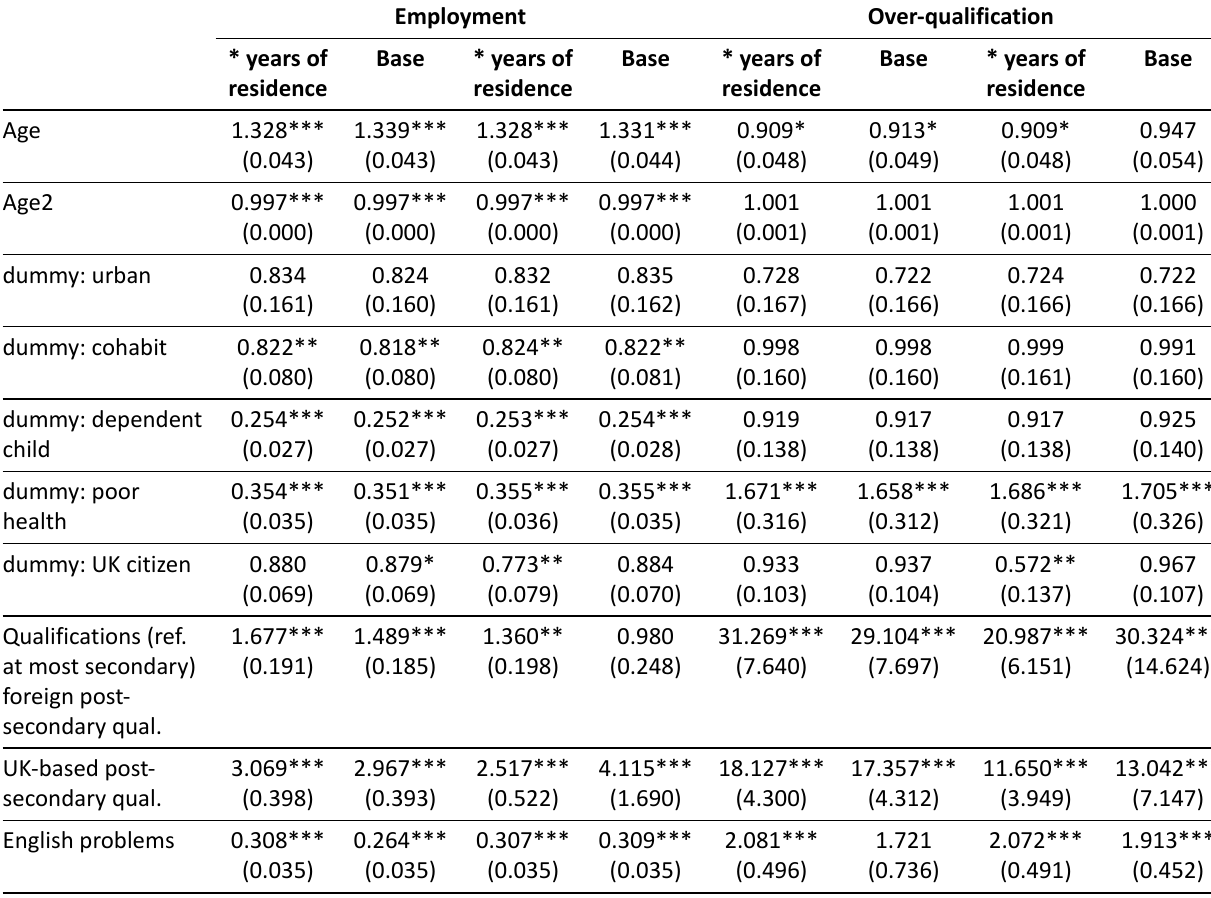
Table A6. Binary logistic regression model with sequential interactions of post-secondary qualifications for